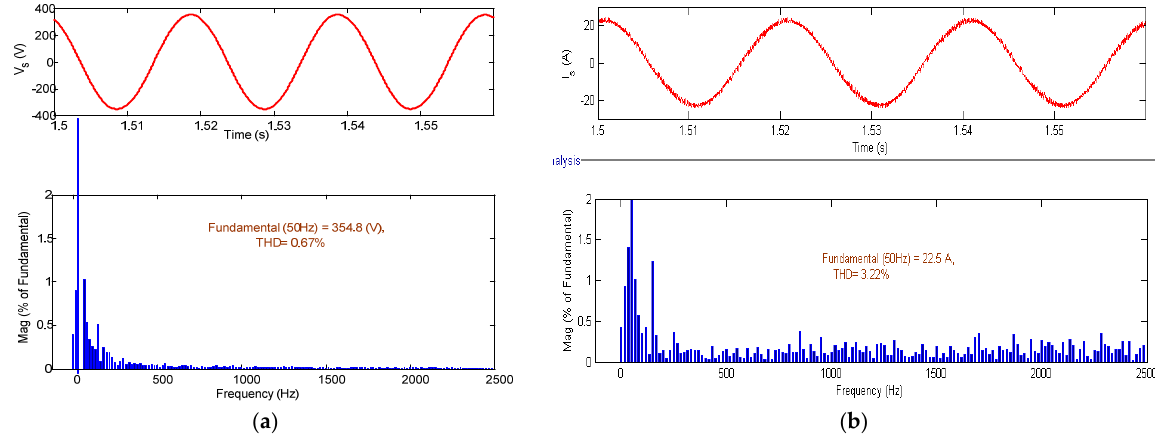
Figure 11. Performance of the Wind power unit with the nonlinear load when the wind speed changes from 11 m/s to 13 m/s.